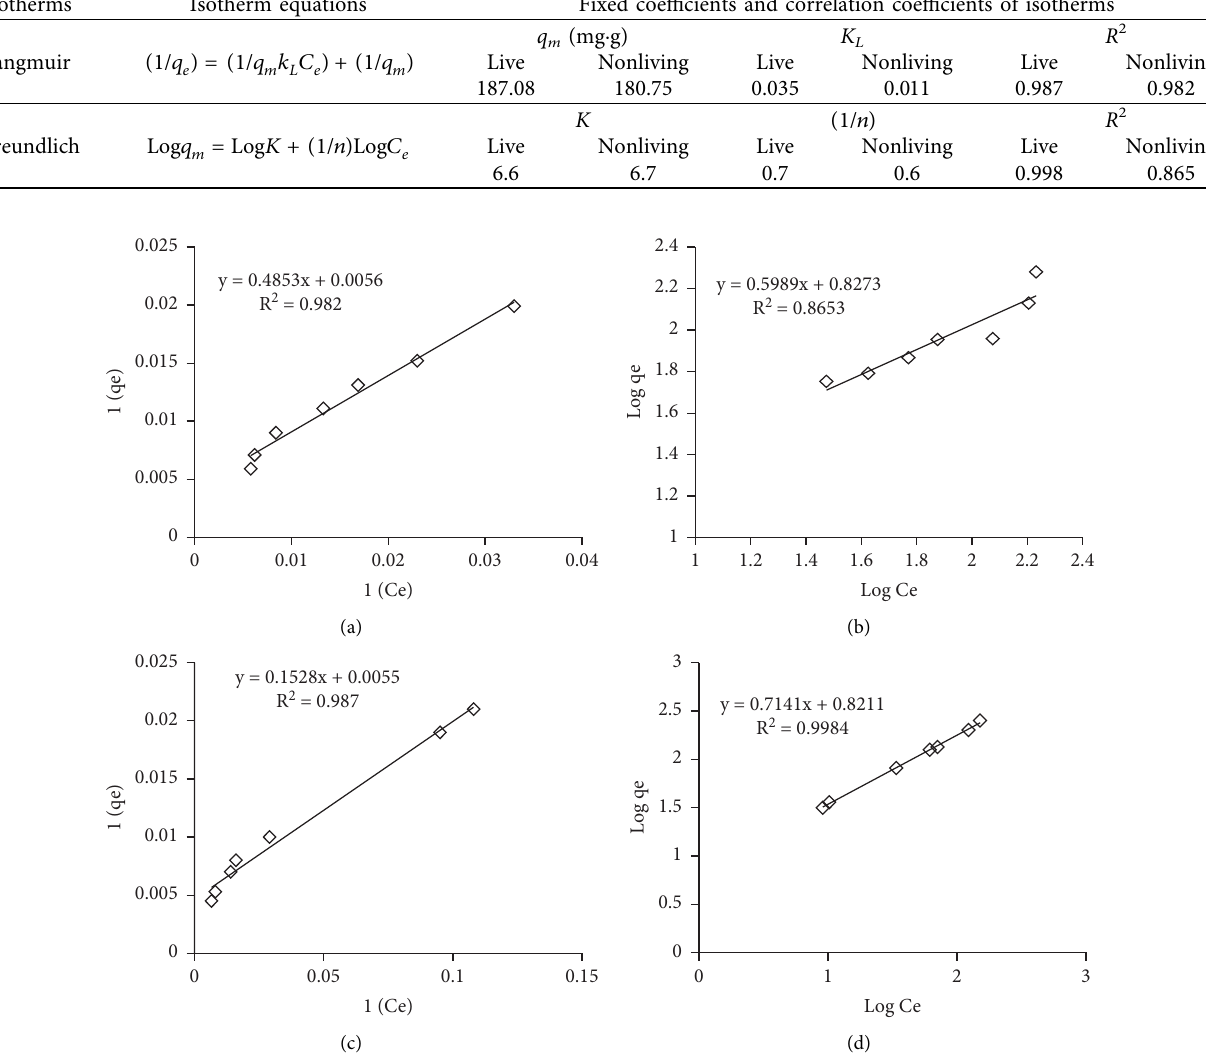
Figure 7: Isothermal models of the Pb (II) adsorption process by nonliving and living biomass of Penicillium notatum . (a) Langmuir, living state. (b) Freundlich, living state. (c) Langmuir, nonliving state. (d) Freundlich, nonliving state.